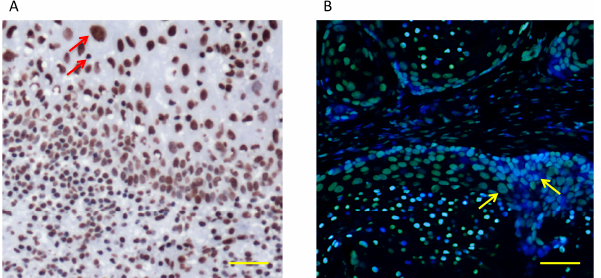
Figure 1. Changes in nuclear morphology may be associated with epigenetic modifications and deregulation of gene expression. ( A ) Immunocytochemistry of a head and neck squamous carcinoma (HNSCC) tumor sample stained for acetyl-H3 (Lys9). Note differences in the nuclear size and high levels of histone acetylation (red arrows, dark brown); ( B ) Immunofluorescence of an HNSCC tumor sample stained for acetyl-H3 (Lys9). Note differences in the nuclear size and protein accumulation depicted by yellow arrows. Scale bars represent 50 μ m. Experimental procedure is described in [88]. Int. J. Mol. Sci. 2017 , 18 , 1506